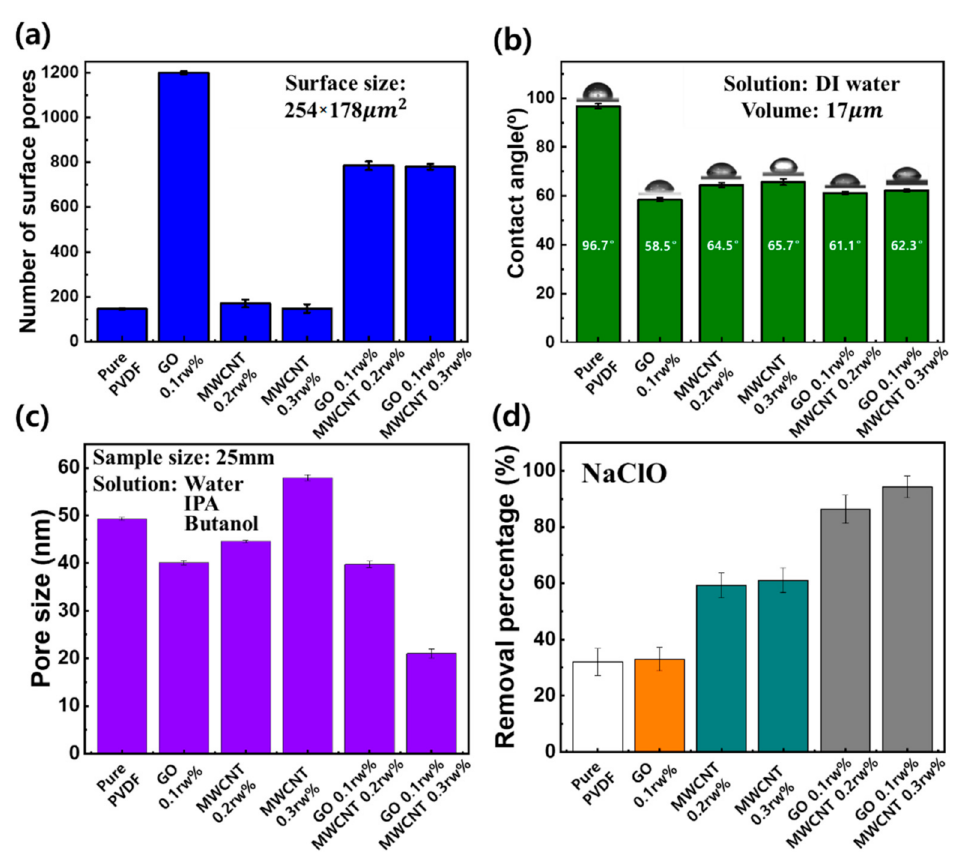
Figure 3. ( a ) Number of surface pores, ( b ) water contact angle, ( c ) pore size distribution, and ( d ) removal percentage of free residual chlorine (NaClO) with a single membrane